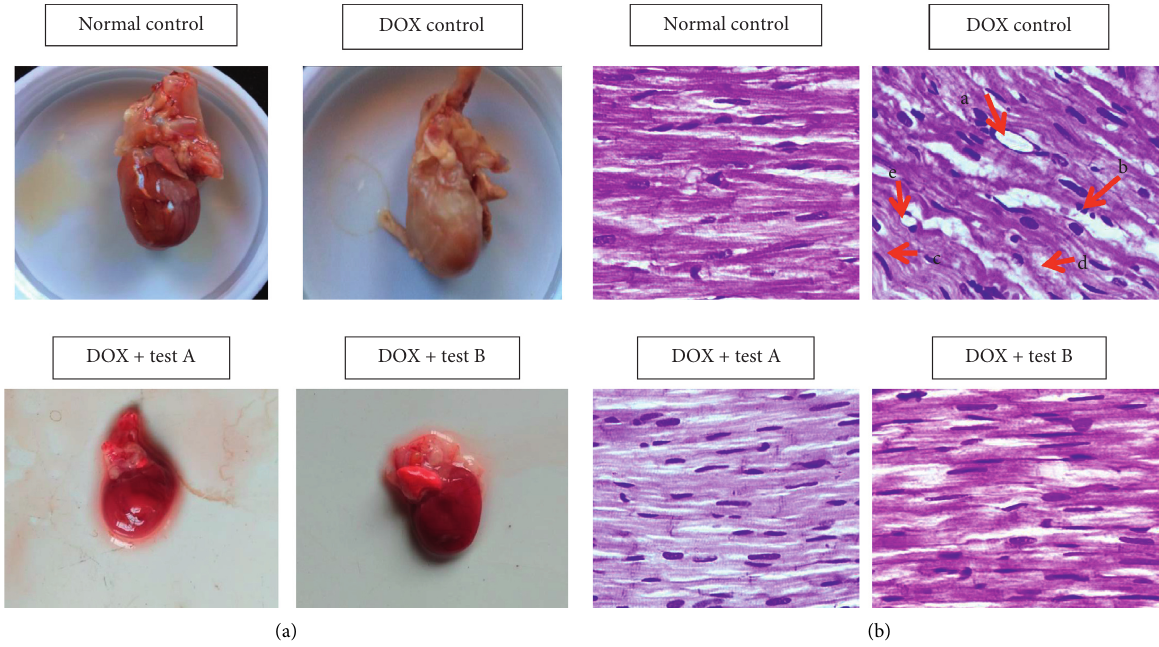
Figure 6: (a) Gross examination of the heart, (b) longitudinal section of cardiac tissue stained with H & E under 400X, (a) intermuscular edema, (b) infiltration with inflammatory cells, (c) myofibrillar loss, (d) cardiomyocytes degeneration, and (e)